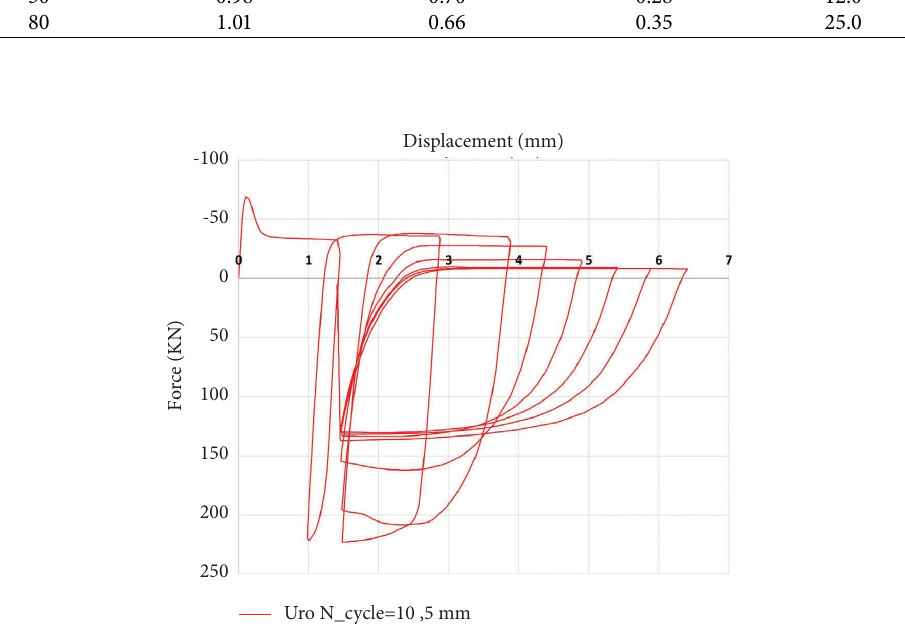
Figure 13: Te displacement-force curve of steel ring contact element in ten